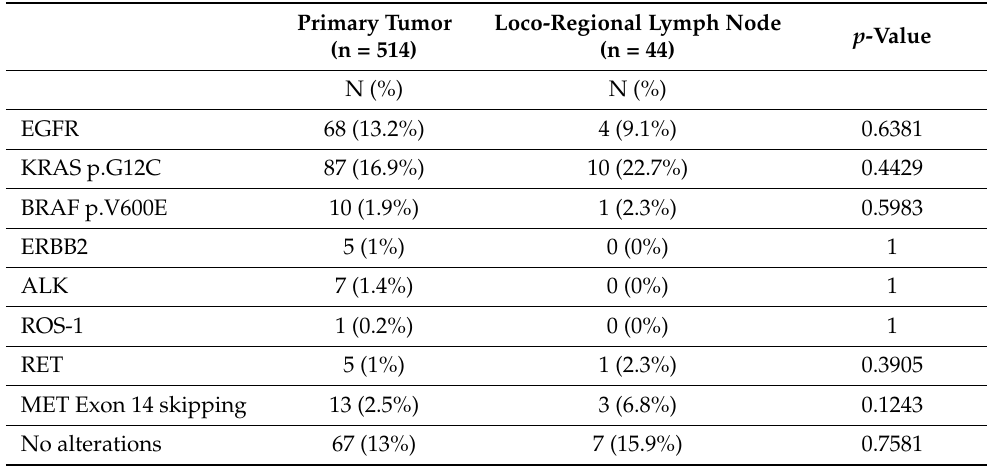
Tumors with non-ACA histology were found in 21.6% (156/723) of the tested early-stage NSCLC and in 21.4% (177/650) of the advanced-stage NSCLC. In both groups, significantly lower frequencies of currently actionable driver mutations than in ACAs were detected: 10.9% (17/156) vs. 37.0% (210/567) in early stages ( p < 0.001) and 14.7% (26/177) vs. 37.3% (242/650) in advanced stages ( p <